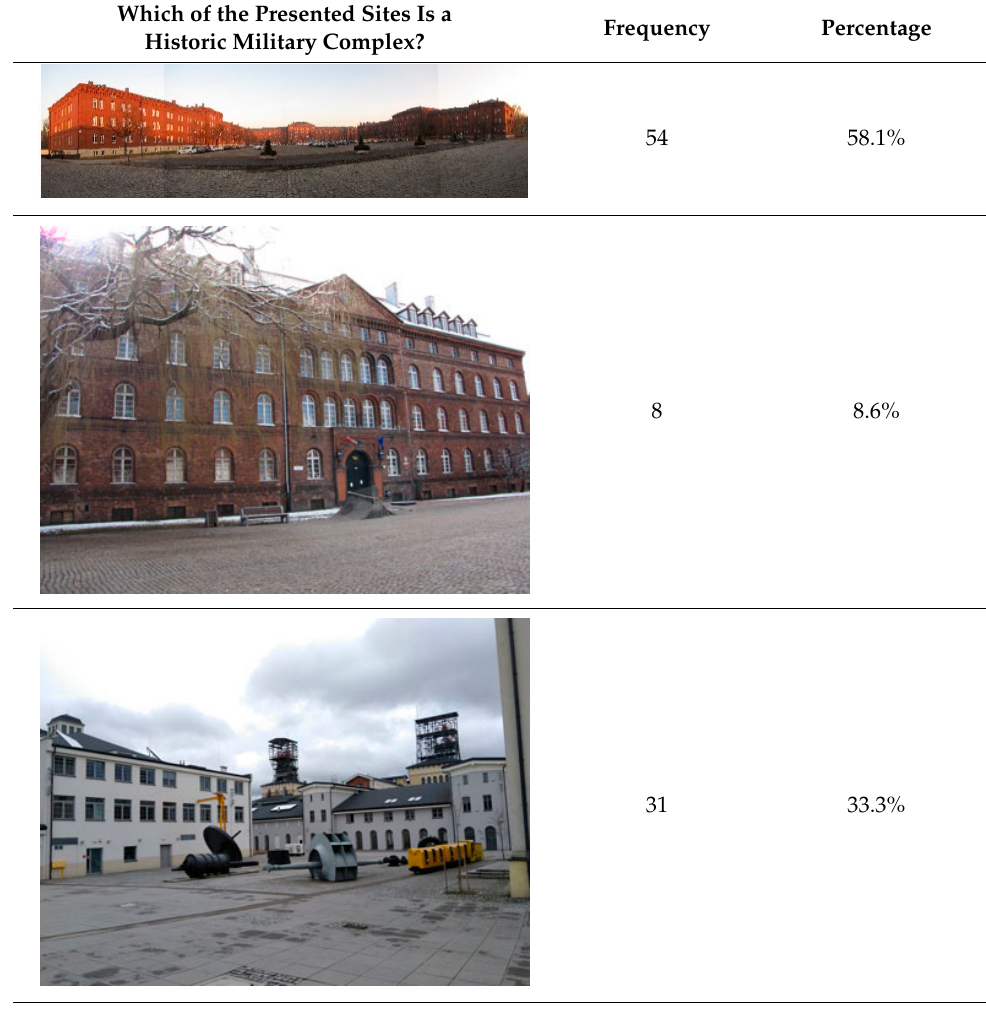
Table 2. Example of a frequency distribution table for the survey. Which of the Presented Sites Is a